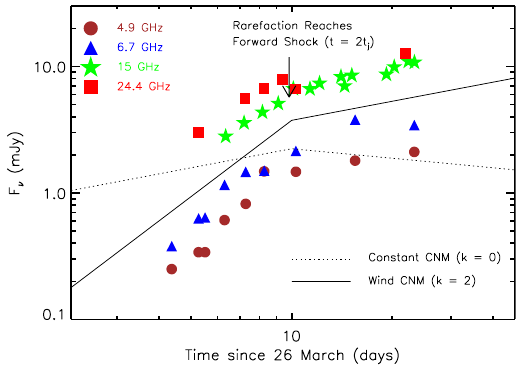
Figure 3. Radio light curves of Swift J1644 + 57 from Zauderer et al. (2011) at several frequencies below the self-absorption break. The achromatic break observed at t ∼ 10 days occurs when the rarefaction wave (produced once the reverse shock crosses the initial shell of ejecta) catches up to the forward shock. Shown for comparison are the predicted light curves (arbitrary normalization) if the CNM density has a constant ( dotted line ; k = 0) or a wind-type ( solid line ; k = 2) radial profile (from